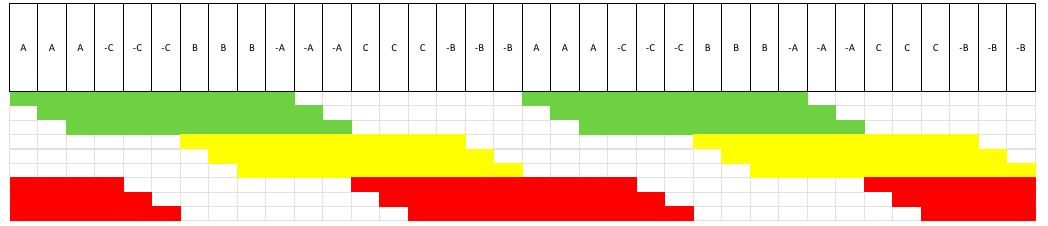
Figure 10. Winding schema of E-engine.